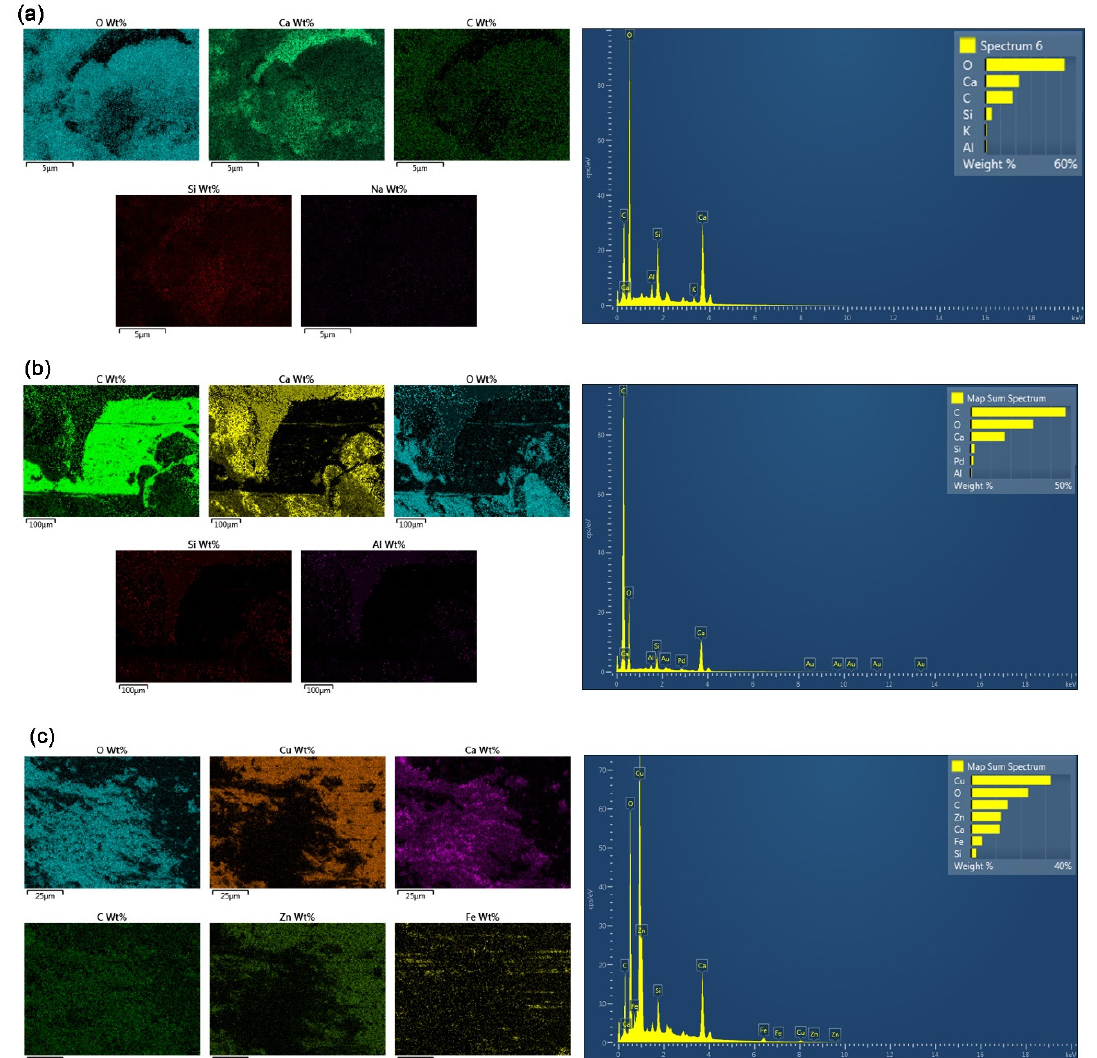
Figure 9. Elemental composition mapping of ( a ) HySSC-10 M sample, ( b ) interface between synthetic fiber and concrete matrix, and ( c ) interface between steel fiber and concrete matrix.